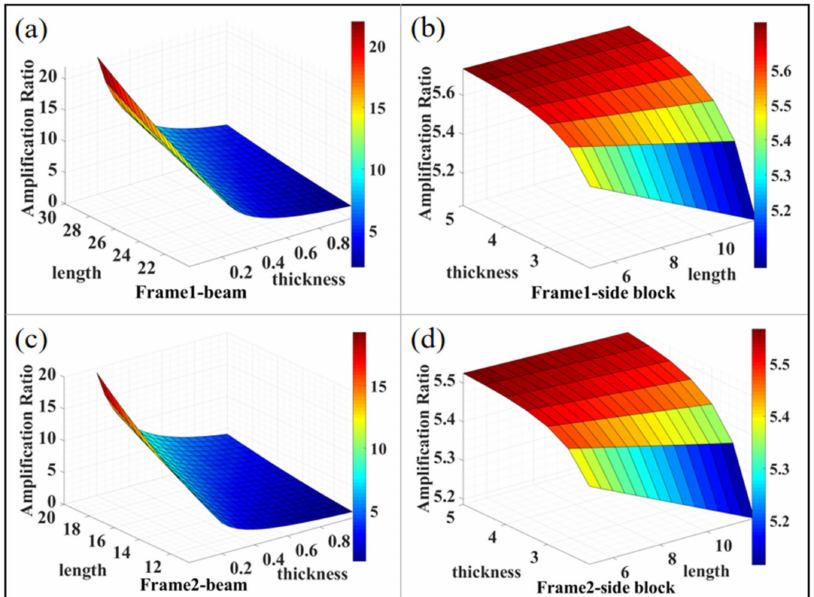
Figure 8. Effect of length and thickness of beams and side blocks on the magnification ratio of a single rhombus frame. ( a ) Effect of beams on frame 1; ( b ) Effect of side blocks on frame 1; ( c ) Effect of beams on frame 2; ( d ) Effect of side blocks on frame